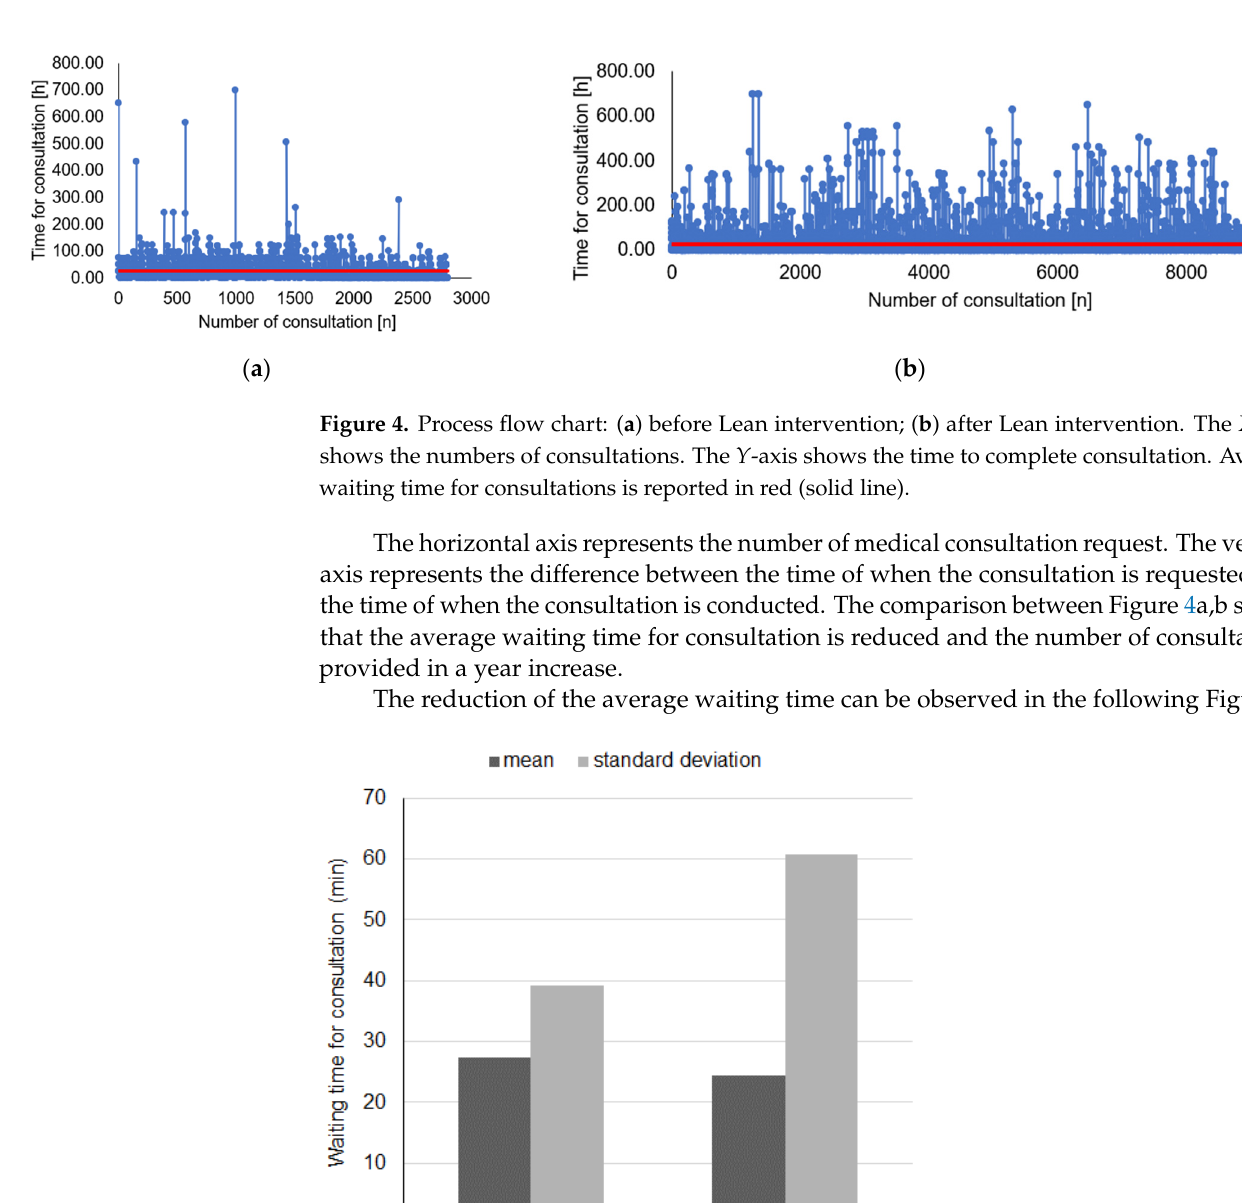
lean approach. The X -axis shows the different mean and standard deviation. The Y -axis shows the waiting time for consultation ranging from 0 to 70